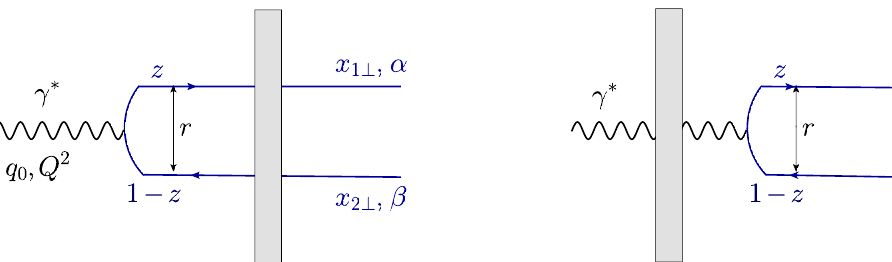
Figure 1. Left: the virtual photon splits before crossing the nuclear shockwave; the originally colourless q ¯ q pair acquires colour via the scattering off the gluons in the target. Right: the virtual photon splits after crossing the target, thus giving rise to a colourless q ¯ q pair in the final state.